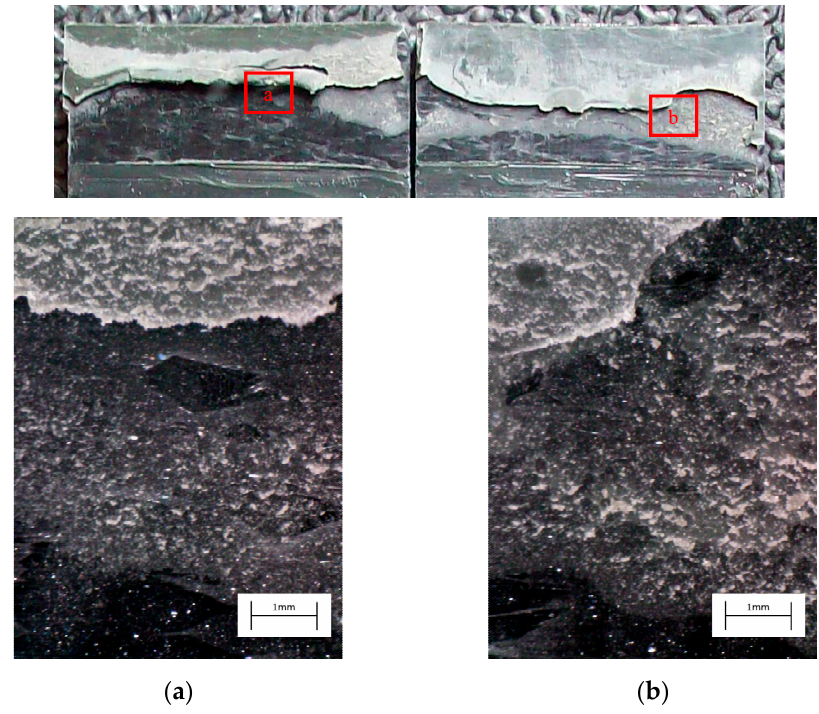
Figure 23. Fracture surface of a specimen pretreated with APPT with D = 10 mm and v = 100 mm/s and subjected to fatigue test, with magnified details ( a ) and ( b ) acquired by microscope.